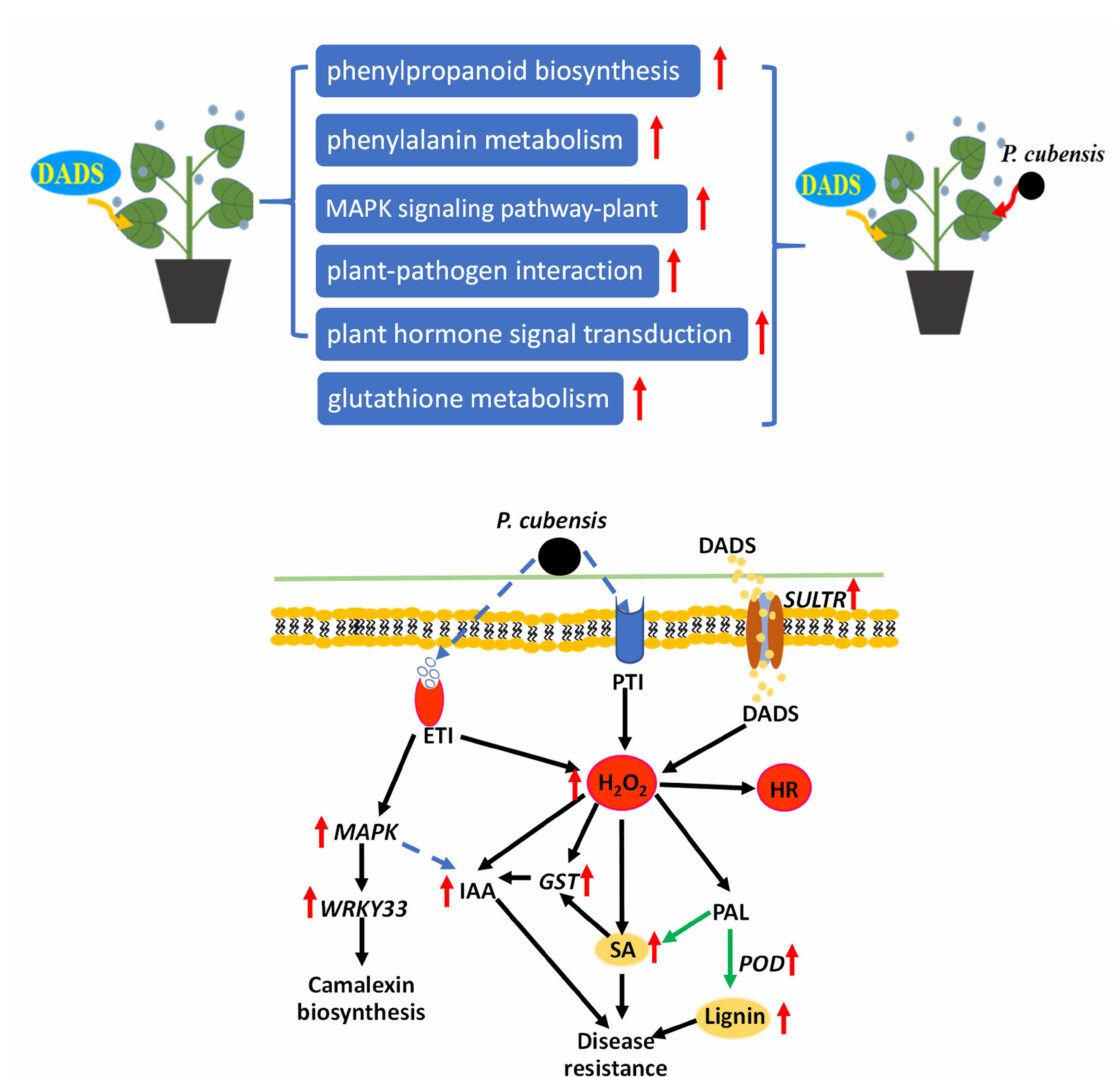
Figure 8. A potential model underlying the enhanced cucumber resistance to P. cubensis induced by DADS. Under the infection of P. cubensis , DADS-treated plants exhibit enhanced disease resistance in comparison with CK plants due to the activation of multifaceted defense machinery in leaves. Red arrows represent up-regulation, green arrows represent synthesis, black arrows represent facilitation, and dashed arrows represent